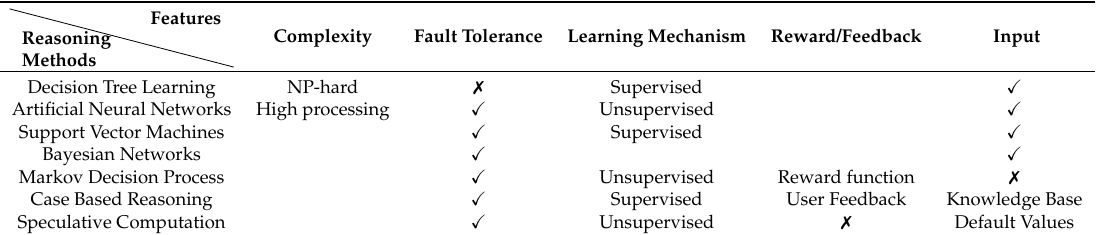
Table 2. Comparison between different reasoning